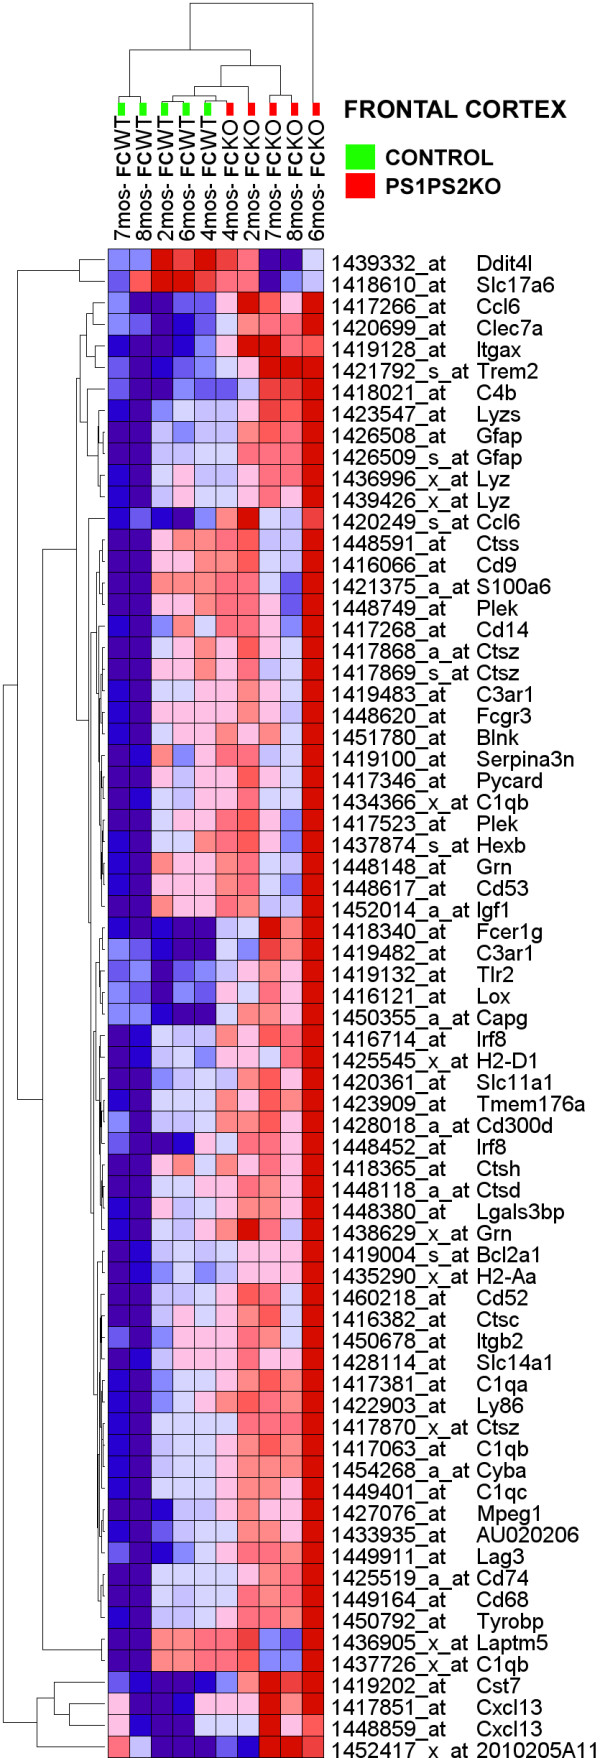
Hierarchical clustering of genes that show differential expression in the FC of PSKO and CNT mice. The numerical data are presented in Additional File 4. Gene probes are clustered in rows (denoted by symbols and probe identifiers), microarrays are clustered in columns (denoted by sample identifiers). Each pixel represents a single, color-coded gene expression value form FC form a PSKO or CNT mouse sample at five developmental ages. Shades of red correspond to the magnitude of expression increase, the intensity of blue corresponds to the magnitude of the reduction in gene transcripts. Note that the frontal cortical PSKO and CNT samples, regardless of developmental age, cluster on different ends of the dendrogram.